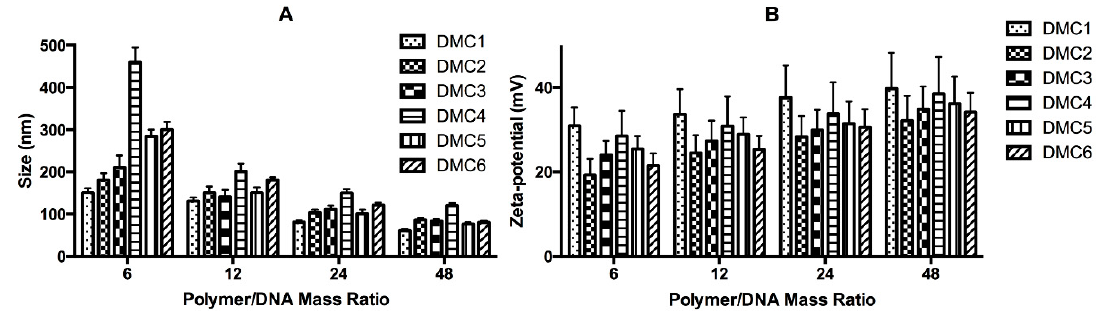
Figure 2. Characteristics of polyplexes prepared from bioreducible poly(amino ether)s and plasmid pCMV-GFP under various polymer/DNA mass ratios. ( A ) Hydrodynamic sizes versus mass ratios; ( B ) Zeta-potentials versus mass ratios.